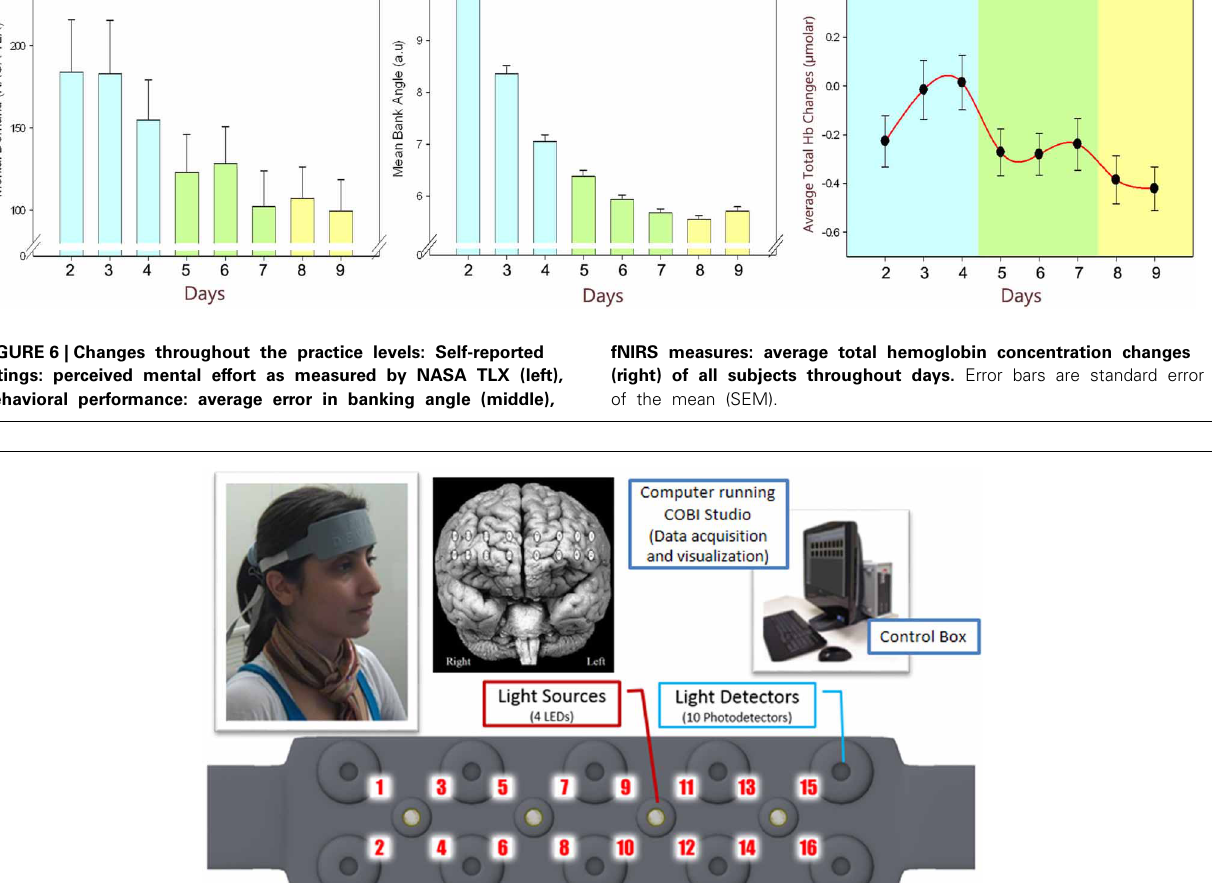
FIGURE 7 | Overview of fNIR system: Computer running COBI Studio (Drexel University) collects data through hardware control box. Flexible Sensor housing 4 LED light sources, 10 photo-detectors provides 16 measurement locations.